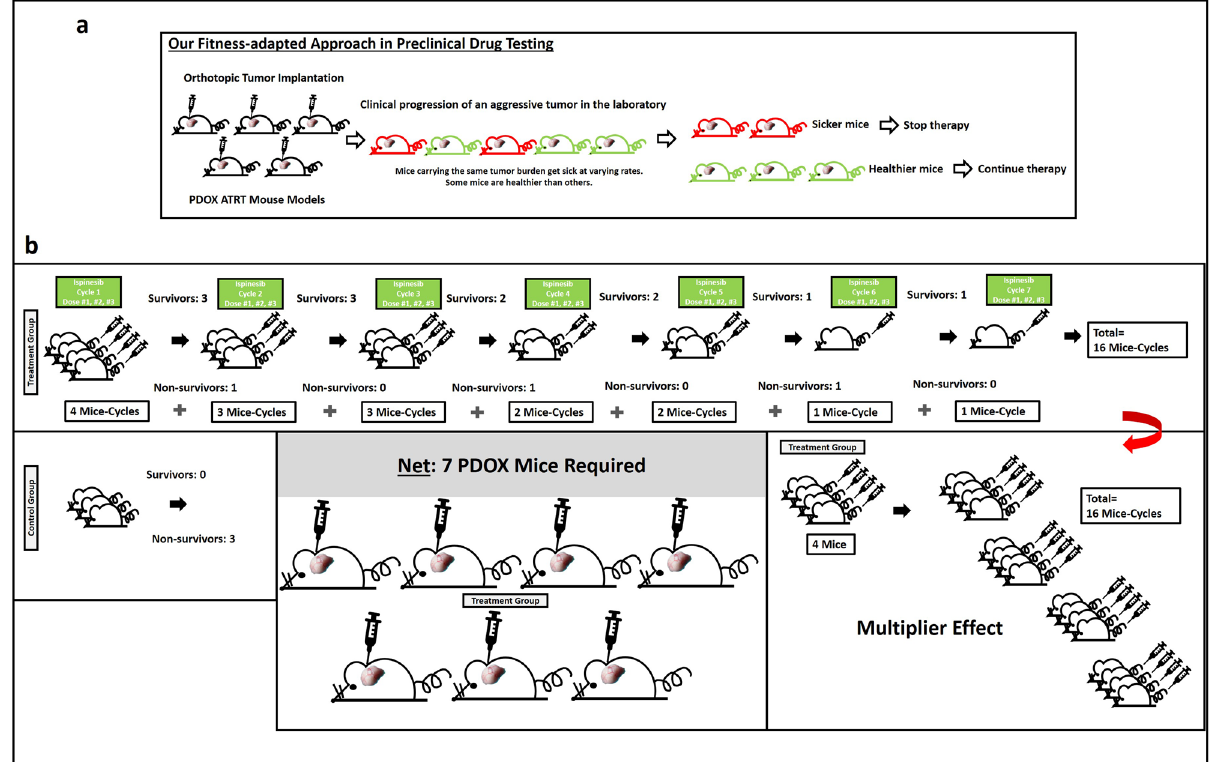
Figure 3. Parallel approach to clinic setting. ( a ) Our fitness-based staging method leverages the concept that mice health status varies despite carrying the same tumor burden. Mice which are healthier, will be able to tolerate additional drug doses during our preclinical testing phase, and by staging their fitness level, we are able to identify and deliver more drug doses to these mice to evaluate the true drug efficacy, instead of a short drug treatment due to their reduced laboratory lifespan. This method enabled us to circumvent a laboratory problem employing such preclinical models of aggressive tumors, with very short laboratory life span, hence a narrow drug delivery time window. Aggressive brain tumors have rapid clinical progression in patients. Some patients become sick more quickly while others remain in overall good health over the treatment course ( for illustration purpose only, ratio of healthier versus sicker patients varies in different settings) . Patients in good overall health status will be fit to receive further cycles of therapy. In contrast, sicker patients will not be able to tolerate further therapy. ( b ) Multiplier effect of our fitness-based approach necessitated only 4 PDOX mice in the treatment group (example shown here for Batch B experiment), yielding a net 16 mice-cycles of drug treatment. This lessened animal numbers for drug testing, hence reducing the cost of preclinical studies. Further, our approach enabled healthier mice to receive a higher cumulative drug dose over a longer time period, to evaluate the in-vivo drug efficacy against the tumor. A statistically significant improvement in progression-free and overall survival was achieved using small animal cohorts, and this effect was replicated (Batch A and Batch therapy, many of these animals survived to continue receiving additional cycles of ispinesib (Figs. 2c–f, S2). This approach significantly prolonged the overall survival of ispinesib-treated mice compared to untreated controls (Fig. 2f, Batch A animals, p = 0.0025, Log-rank test), despite small animal numbers. Ispinesib tripled the median survival in a repeated batch of animals treated using this fitness-based clinical staging system (Fig. 2f, Batch B animals, p = 0.010, Log-rank test). Drug solubility of ispinesib was increased using a different diluent for drug reconstitution in Batch B animals (see “Materials and methods”). Additionally, this clinical staging approach was similarly useful in capturing the progression-free survival of mice (survival time from tumor implantation to Stage 3 and 4, Figs. 2e, S4) and demonstrated an improved progression-free survival with ispinesib therapy. Among Batch A animals which received 2 cycles of ispinesib therapy, one mouse brain did not display obvious tumor burden on serial sectioning with subsequent hematoxylin and eosin staining (Fig. S5B). Our fitness-adapted approach of drug administration yielded a multiplier effect by enabling more mice to undergo additional cycles of therapy (a treatment group of 4 mice with a net effect of 16 mice-treatment-cycles over 7 drug cycles, Figs. 3b, S2B) in contrast to the conventional approach of fixed drug-dose-duration regimen, whereby the drug is administered over the same fixed duration for every mouse in the treatment cohort (Fig. 1b).